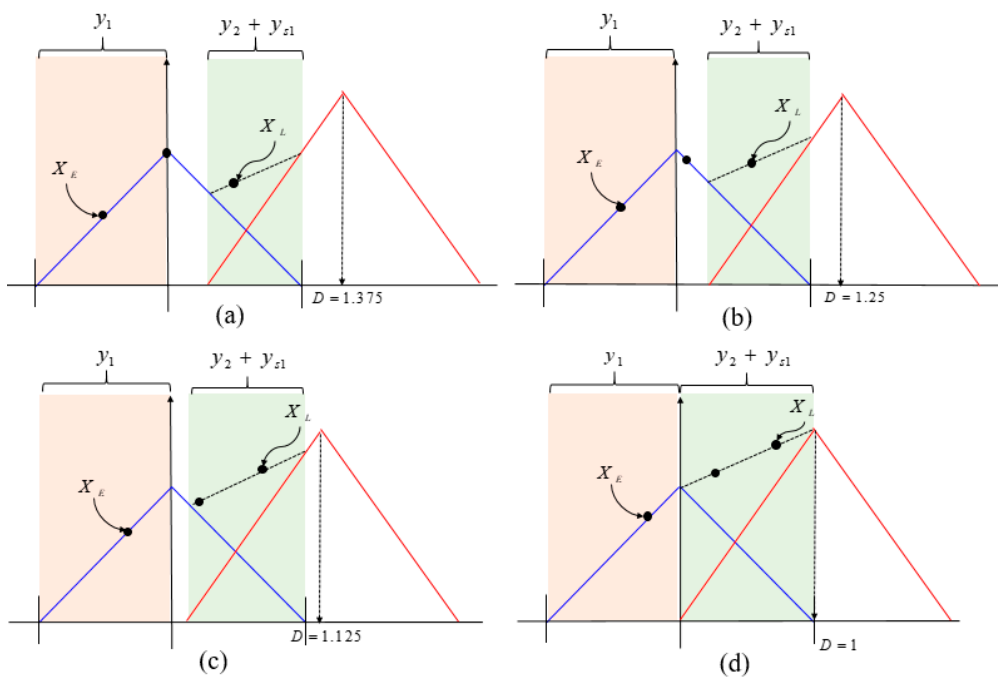
Figure A1. ACF snapshots with i from 1 to 4. (a) D = 1.375; (b) D = 1.25; (c) D = 1.125; (d) D = 1.